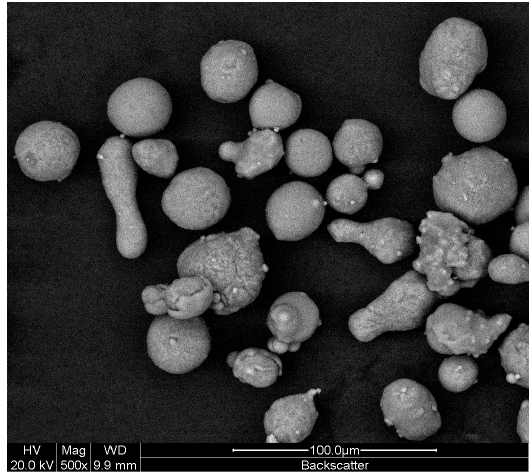
Figure 8. BSE image of low oxygen Al powder. Table 6. Composition of Al powder.